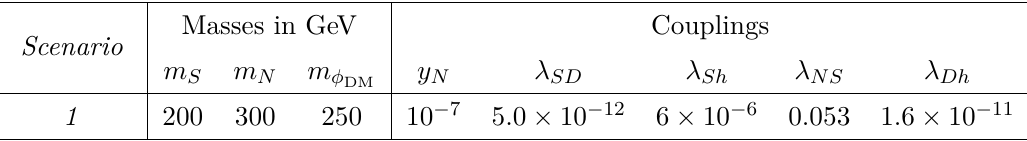
Table 2 . The choices of masses and couplings for Scenario-1